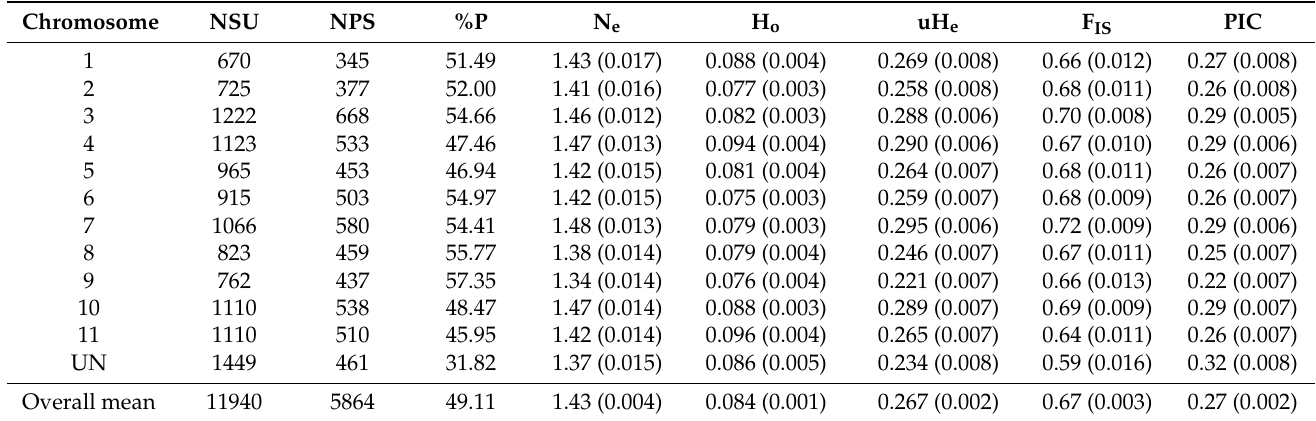
Table 1. Genetic diversity within and among 90 cowpea accessions genotypes based on 5864 SNPs